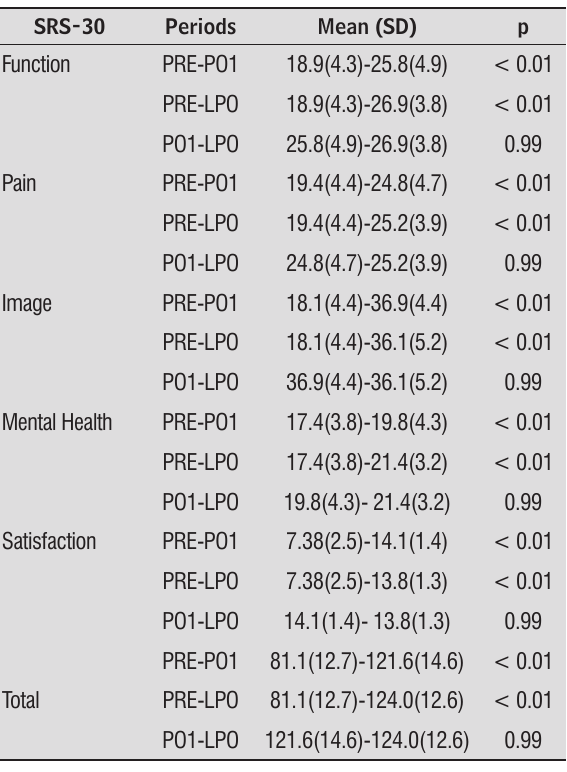
Table 1 - Comparison of the means of the angles and thoracic distances in the Preoperative (PRE), Postoperative (PO1) and late Postoperative (LPO) periods of the 11 patients evaluated Angles and thoracic distances